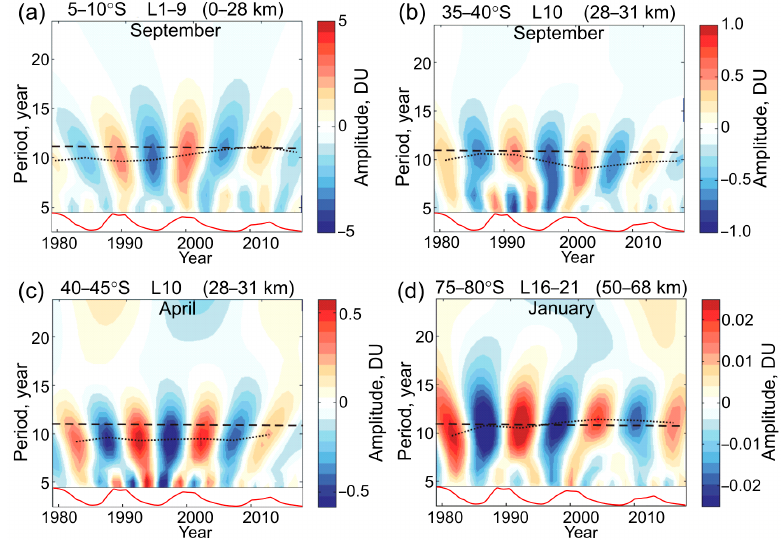
Figure 9. The most prominent quasi-11-year periods in the zonal mean SBUV MOD data at latitudes ( a ) 5–10 ◦ S, L1–9 and ( b ) 35–40 ◦ S, L10, in September; ( c ) 40–45 ◦ S, L10 in April and ( d ) 75–80 ◦ S, L16–21 in